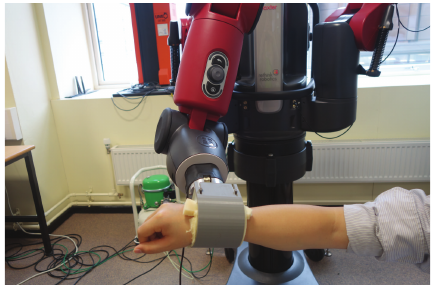
Figure 1: Typical human-robot safe collaboration